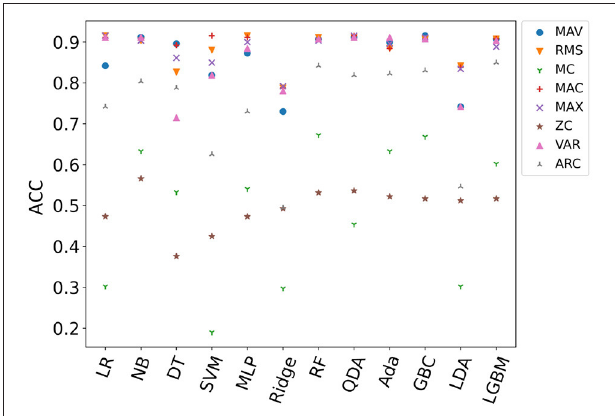
FIGURE 8 | Comparison of the average accuracy of all subjects in different models with single-feature (SF).